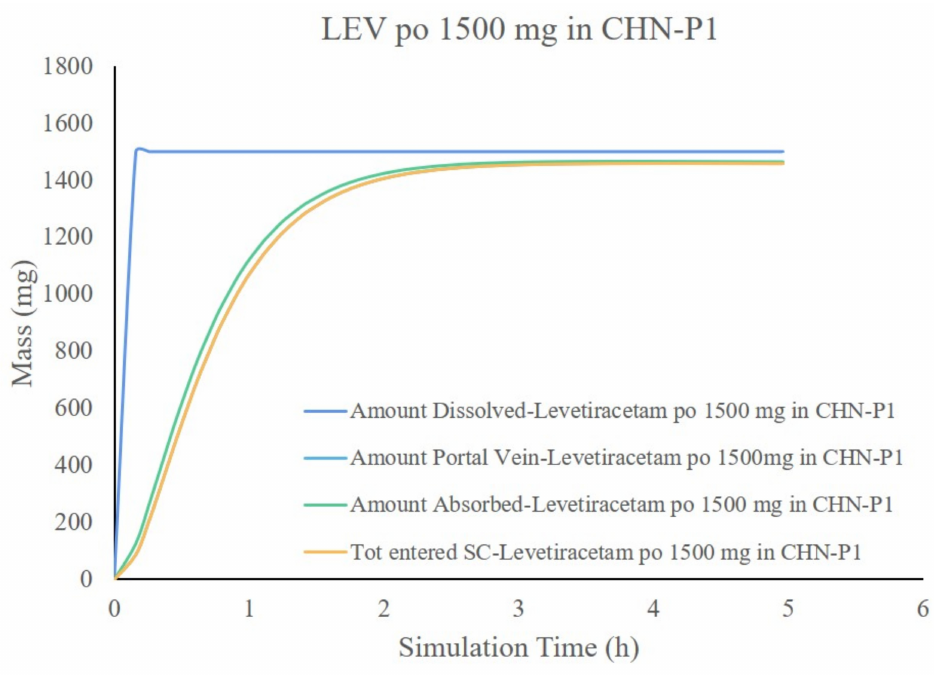
Figure 4. Dissolution and absorption curve of 1500 mg LEV orally in Chinese